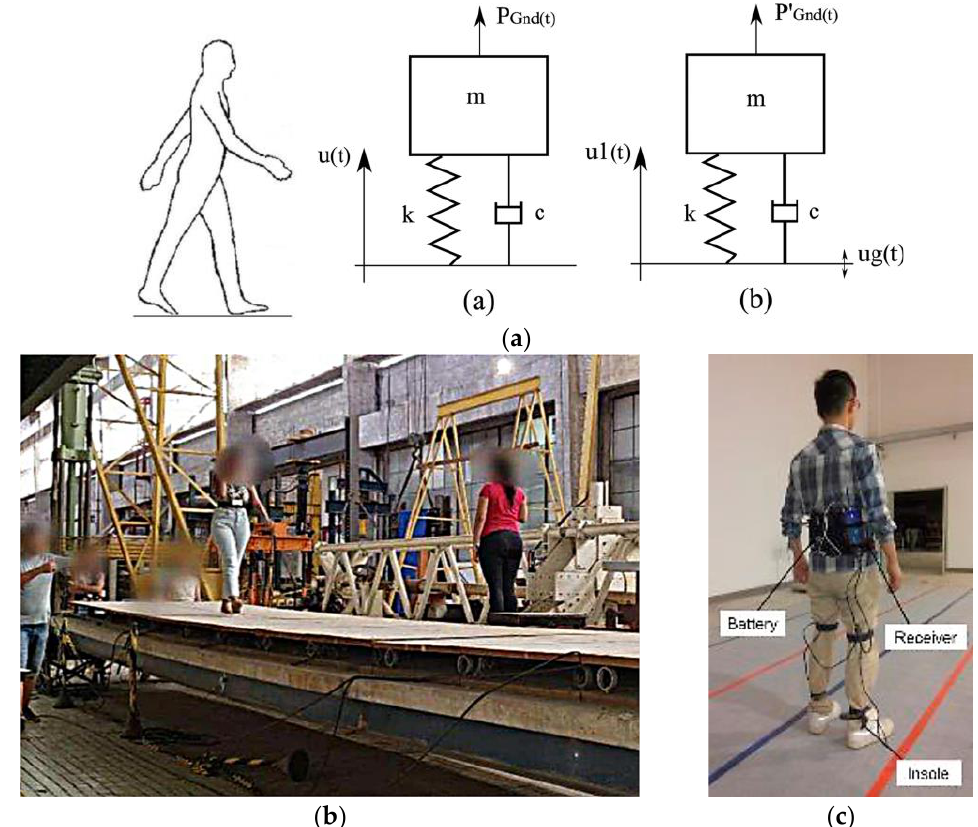
Figure 3. Biodynamic pedestrian models: ( a ) schematic mechanical model of a pedestrian on rigid or flexible structure (figure reproduced from [6] with permission from Elsevier©, copyright license number agreement 5458710774818, December 2022); ( b ) experimental setup for pedestrian walking on flexible laboratory platform (figure reproduced from [7] with permission from Elsevier©, copyright license number agreement 5458711054568, December 2022); ( c ) experimental analysis by Wang et al. to measure the ground reaction force (figure reproduced from [8] with permission from